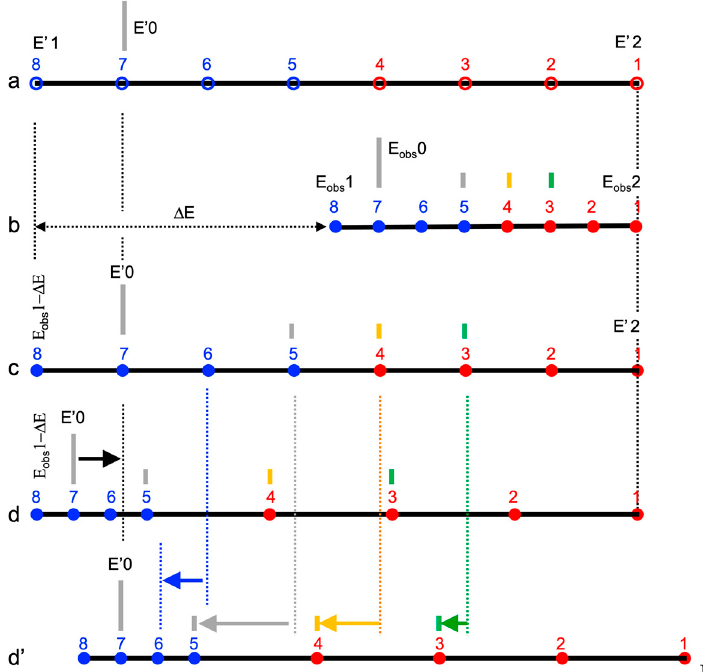
Figure 2. A conceptual NRVS measurement which scans from the higher energy end (E2 ′ ) to the lower energy end (E1 ′ ) and which scans points 1, 2, 3, 4 (red) with 3t s/p and points 5, 6, 7, 8 (blue) with t s/p: ( a ) a targeted theoretical range for the NRVS spectrum (in E ′ ); ( b ) the observed raw energies (at points 1 − 8) when we assume an exaggerated larges Δ E which is half of (E2 ′ − E1 ′ )—that is (E obs 2 − E obs 1) = (½) · (E2 ′ − E1 ′ ); ( c ) the corrected intermediate energies (E ′ ) which map the large amount Δ E onto the 8 data points using universal energy scale Formula (1); ( d ) the corrected intermediate energies (E ′ ) which map the large amount Δ E onto the 8 data points using time-scaled correlation (2); and ( d’ ) the corrected energies in ( d ) with the E 0 position aligned to 0. When the scan is arriving at a middle point between E2 ′ and E1 ′ , the energy drift between the observed E obs and the Δ E corrected E ′ accumulates gradually and continuously, starting from 0 to Δ E = (½) · (E2 ′ − E 1 ′ ) . According to (8), this partial amount should be in general following an exponential decay function vs. the beam-on time (t). Within a